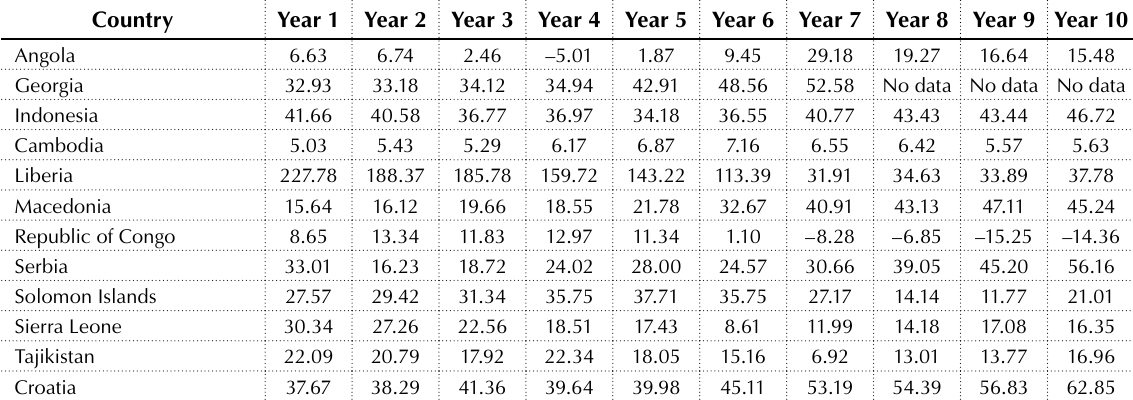
Source: World bank Open